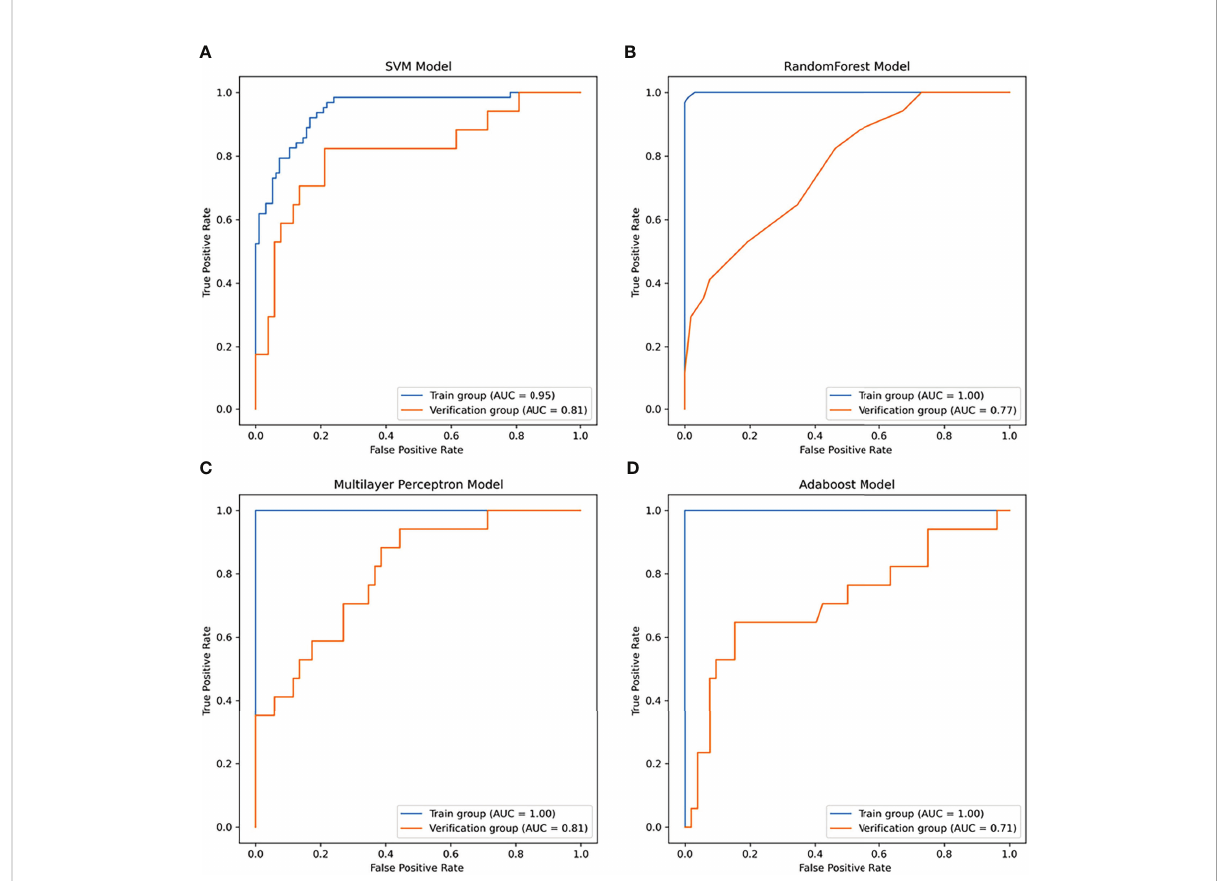
FIGURE 6 The receiver operator characteristic (ROC) curves of the nonlinear models for predicting the growth of the nodules within one year. (A) ROC curve of the SVM model (area under the ROC curve (AUC) = 0.95 in the training group, AUC =0.81 in the validation group). (B) ROC curve of the random forest (RF) model (AUC = 1.0 in the training group, AUC =0.77 in the validation group). (C) ROC curve of the multilayer perceptron (MLP) model (AUC = 1.0 in the training group, AUC =0.81 in the validation group). (D) ROC curve of the Adaboost model (AUC = 1.0 in the training group, AUC =0.71 in the validation